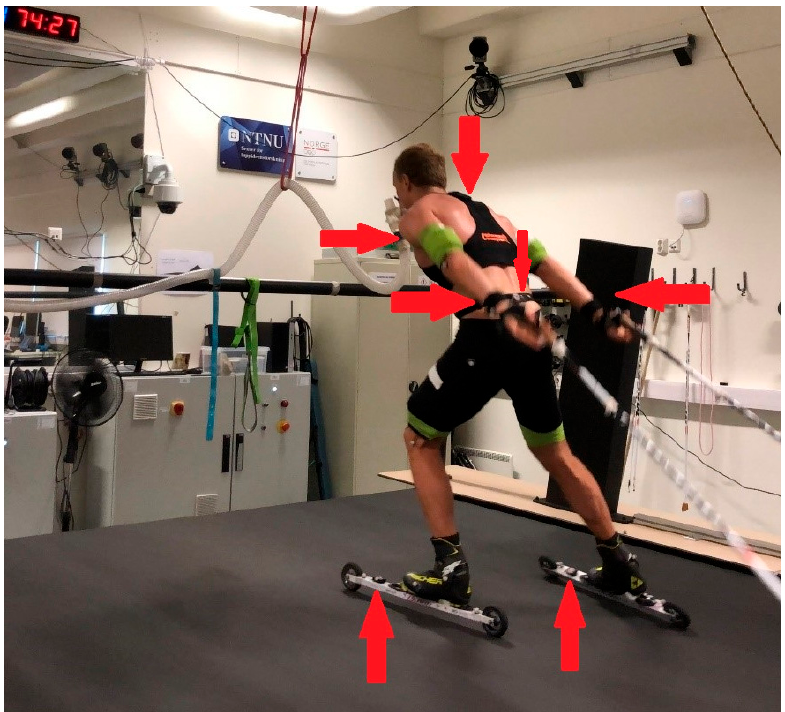
Figure 1. Overview of the experimental setup with an athlete skiing on the treadmill. Red arrows show the position of the